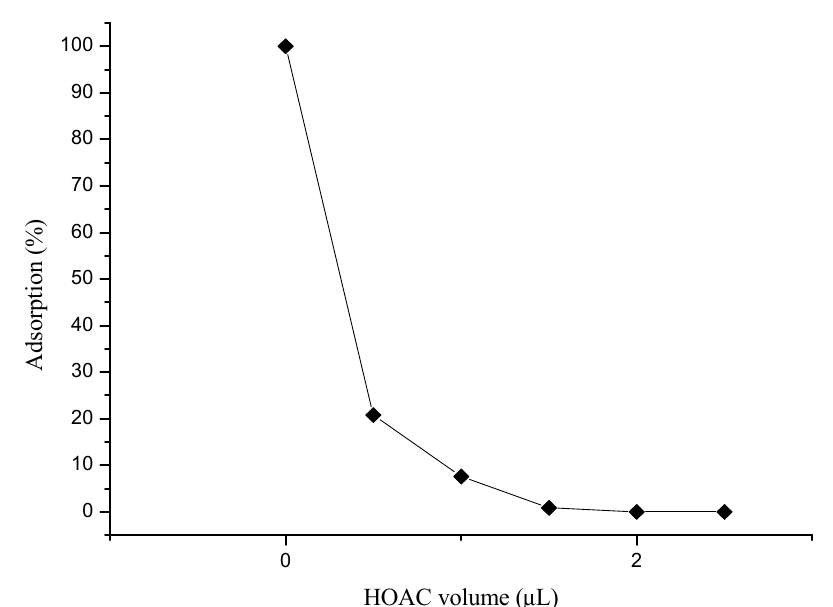
Figure 3. The effect of acidic additive on the percentage of adsorption of 4-aminophenylmercuric acetate on lignin-modified silica gel.